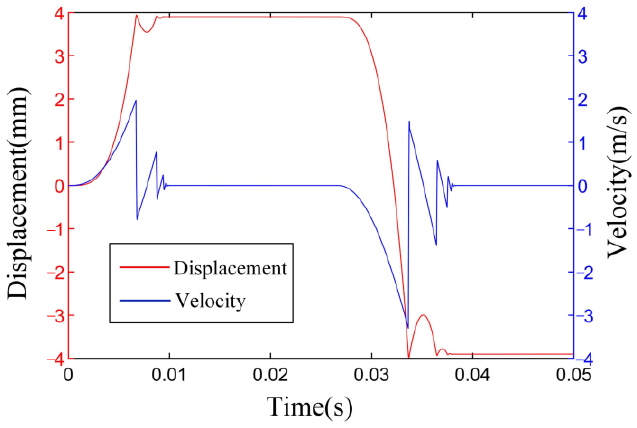
Figure 4. Displacement and velocity curves of coil.